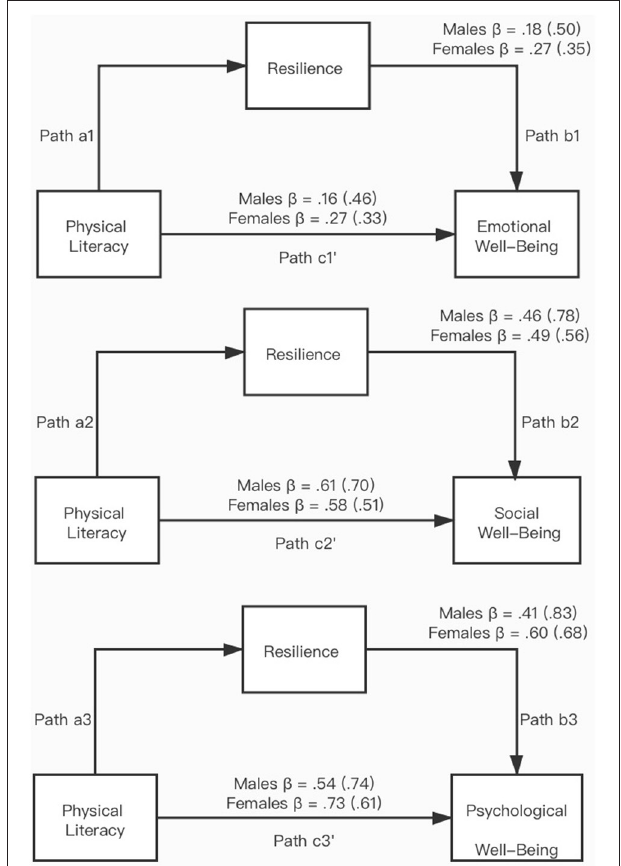
FIGURE 2 | Graphical representation of the mediation model of resilience for physical literacy and the three well-being dimensions of mental health.